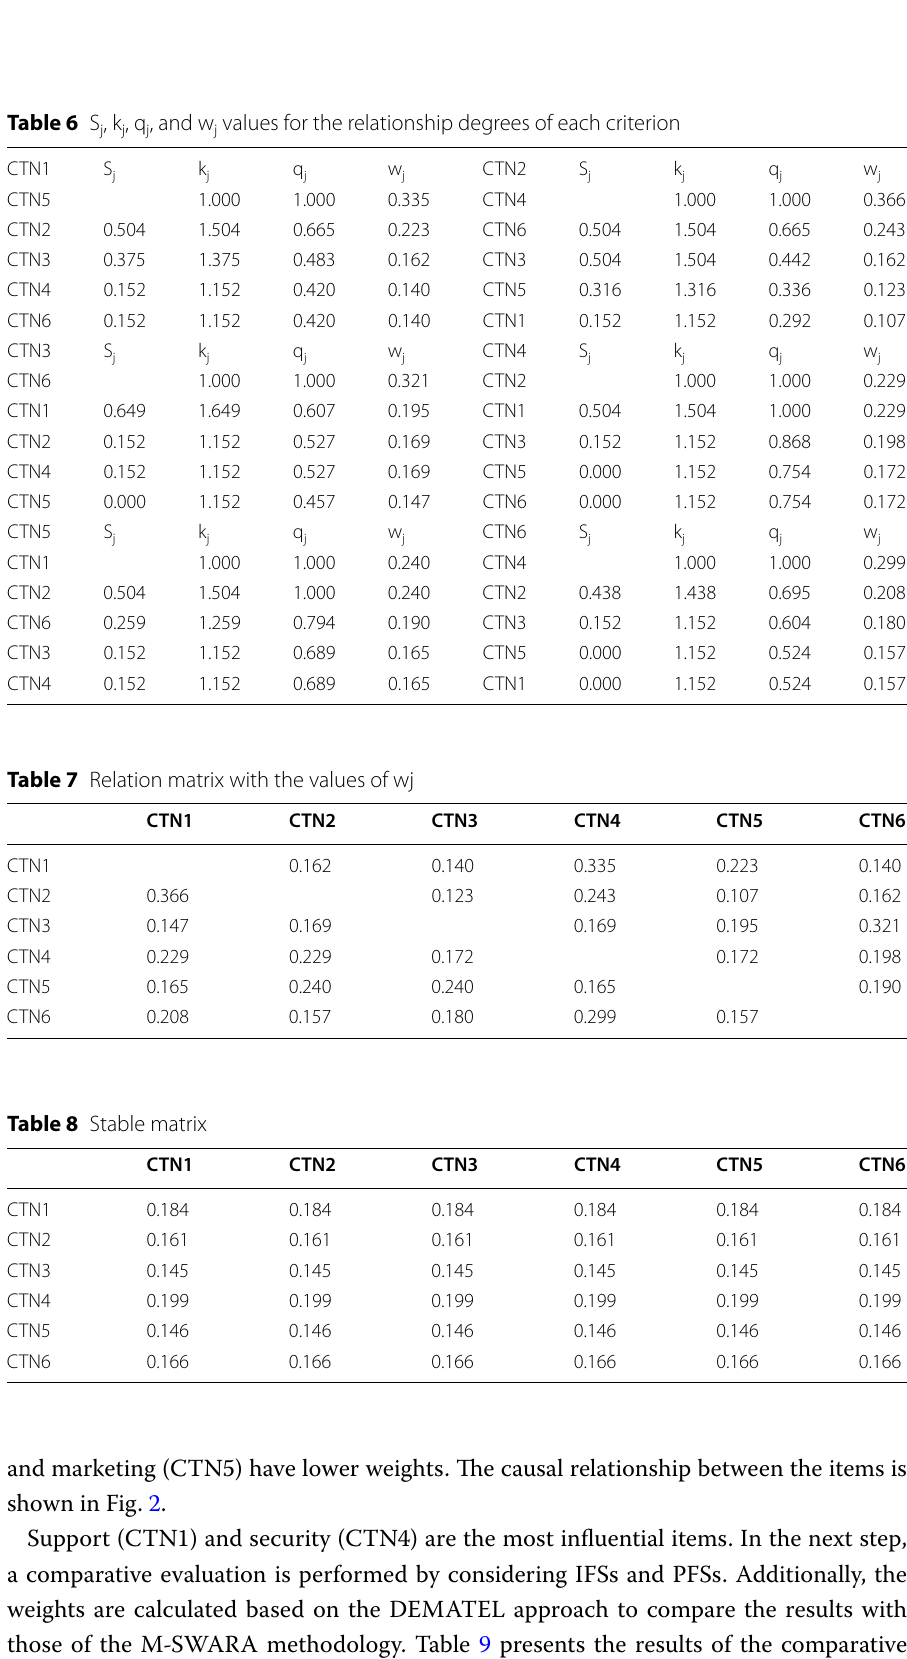
, k , q , and w values for the relationship degrees of each criterion j j j j